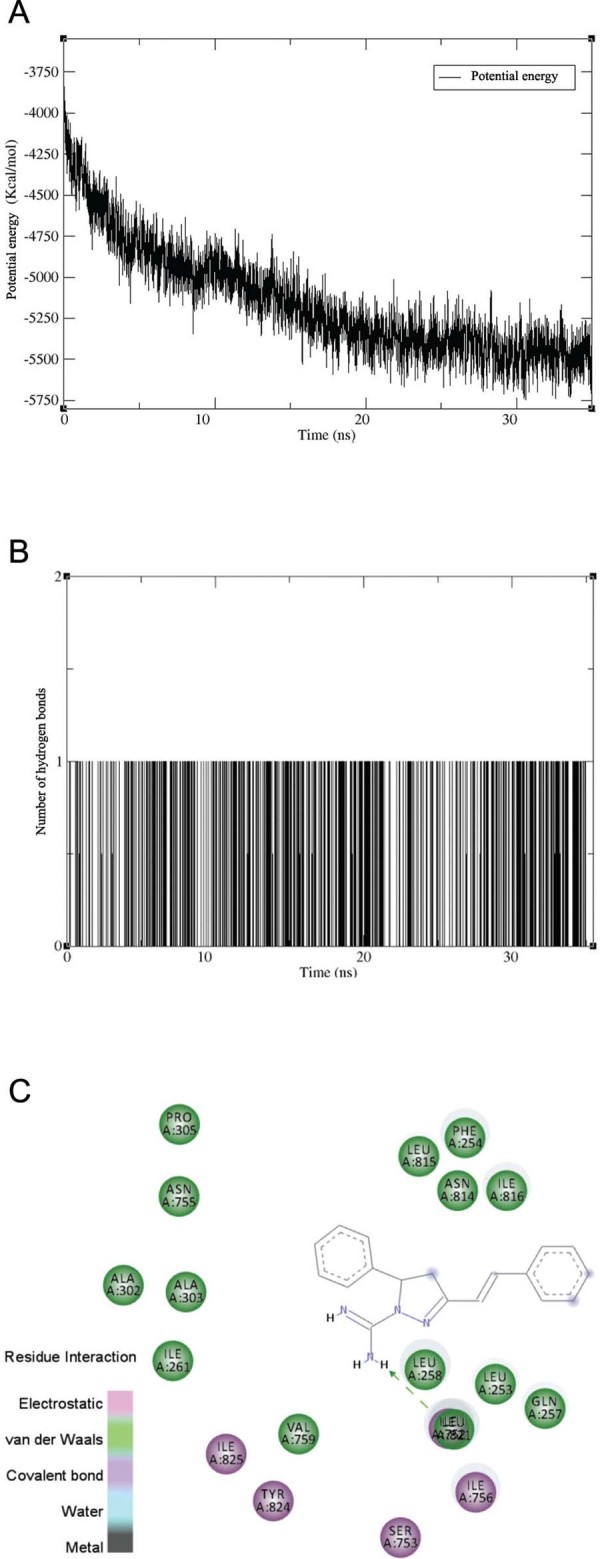
: molecular dynamics (MD) simulation of the Tx001-PfATP6 complex for 35 ns.
(A) Potential energy; (B) number of hydrogen bonds that occurred during the
simulation ranging from 1 to 3; (C) 2D diagram of intermolecular interactions
between Tx001 and PfATP6.